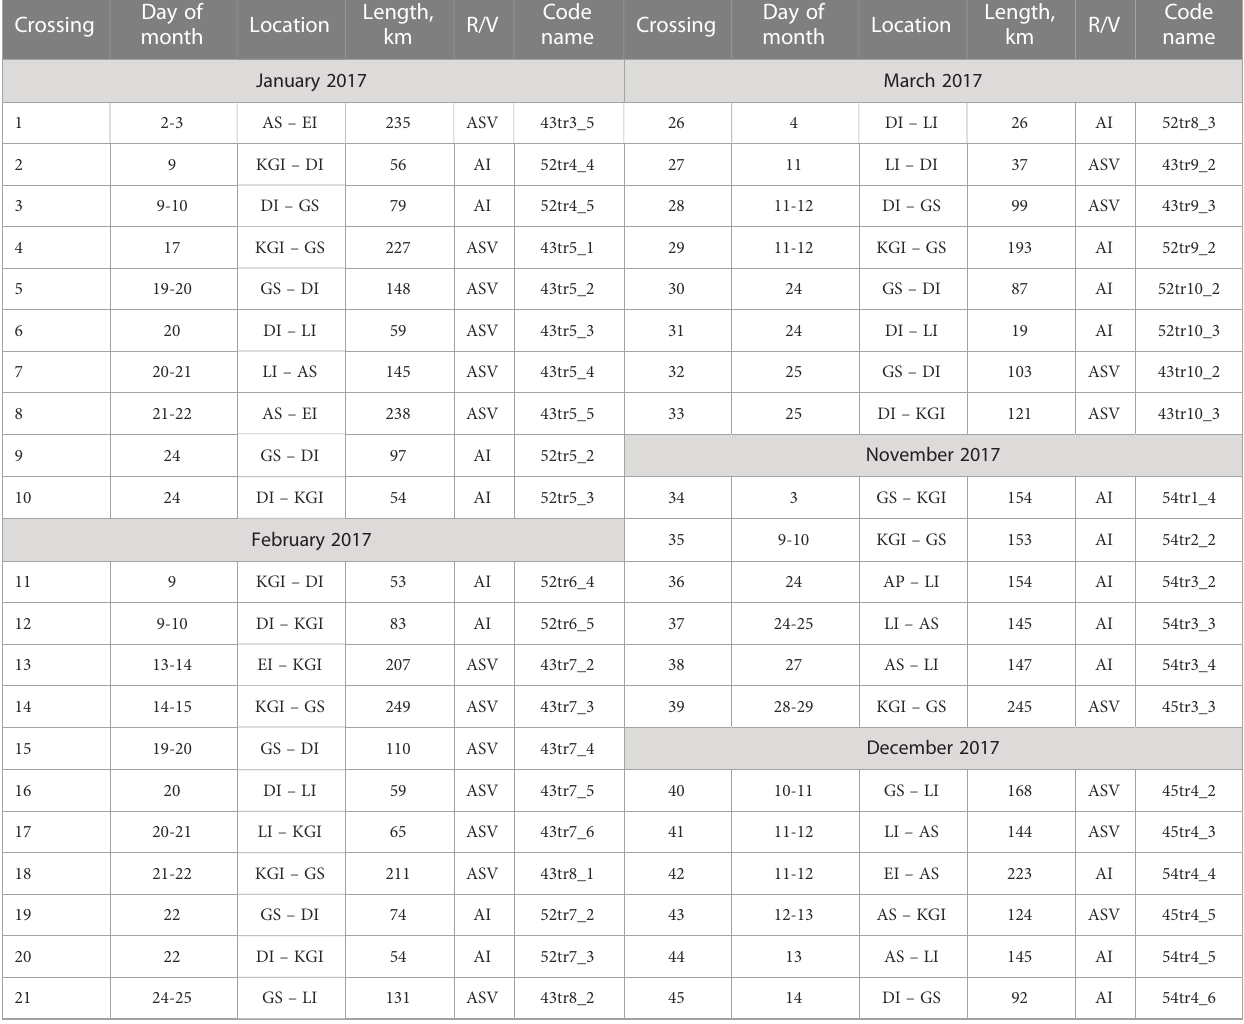
TABLE 1 Transects in the BS with SADCP measurements in 2017 analyzed in this work.